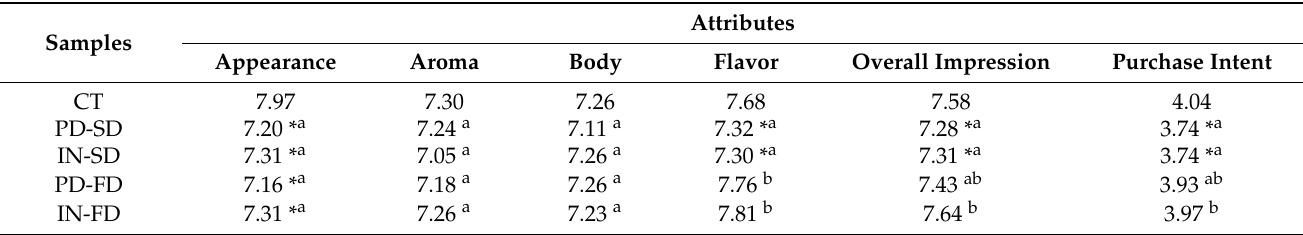
Table 3. Means of the hedonic scores obtained in the sensory analysis of the dairy beverages with added green